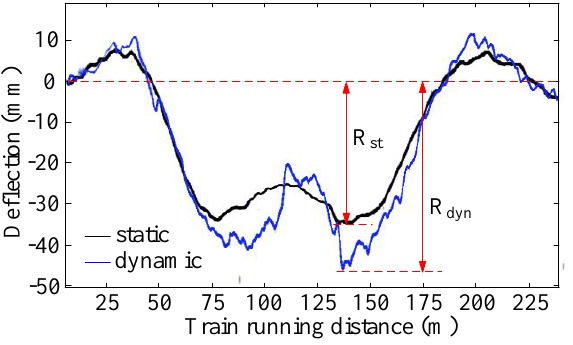
Figure 9. Comparison of time history curves of the static and dynamic deflection when two freight trains run on the bridge.